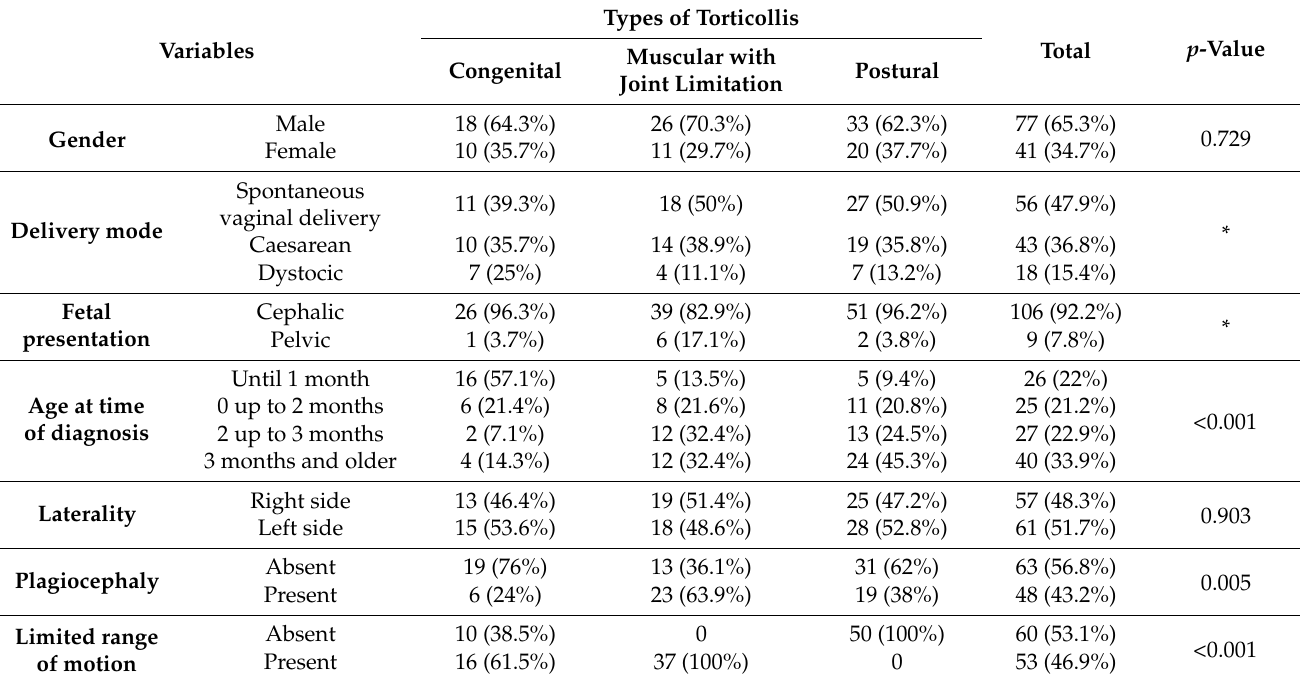
Table 3. The association between the torticollis types and the qualitative